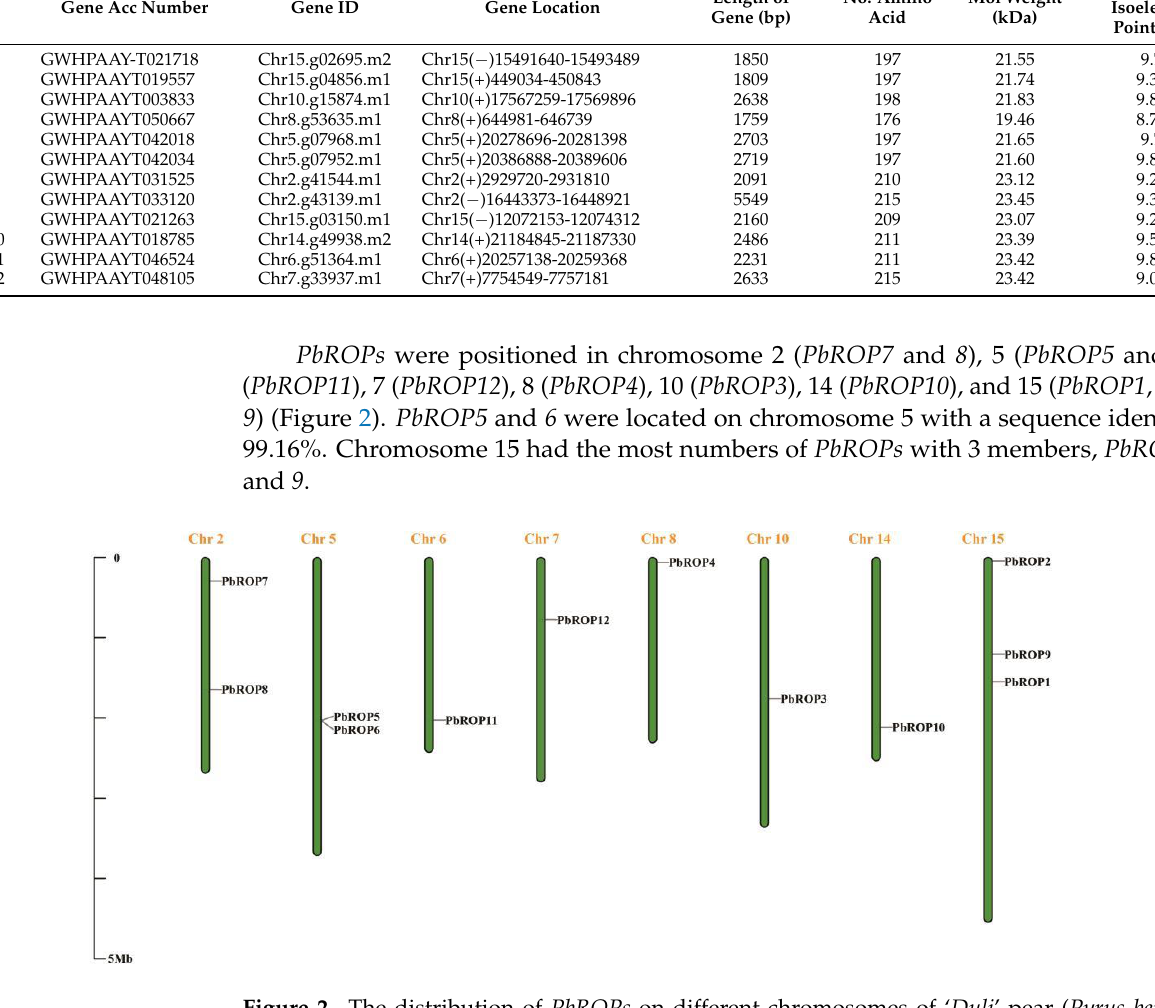
Figure 2. The distribution of PbROPs on different chromosomes of ‘ Duli ’ pear ( Pyrus betulifolia Bunge). The chromosome number is indicated on the top of each chromosome. Base-pair positions are indicated on the left vertical line (0 – 5 Mb).